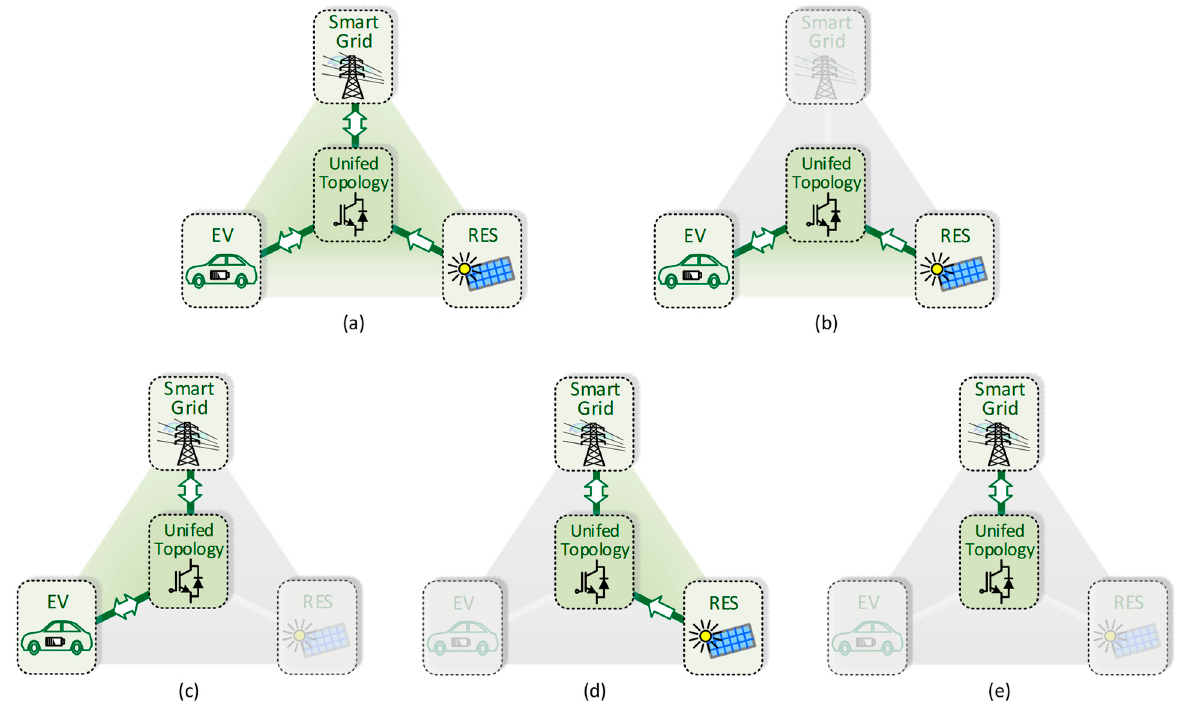
Figure 1. Contextualization of the proposed unified topology connected to the smart grid: ( a ) Inter- facing the EV and the RES with the power grid (with or without active power filtering); ( b ) Interfacing only the EV with the RES; ( c ) Interfacing only the EV with the power grid (with or without active power filtering); ( d ) Interfacing only the RES with the power grid (with or without active power filtering); ( e ) Interfacing only the power grid with active power filtering.